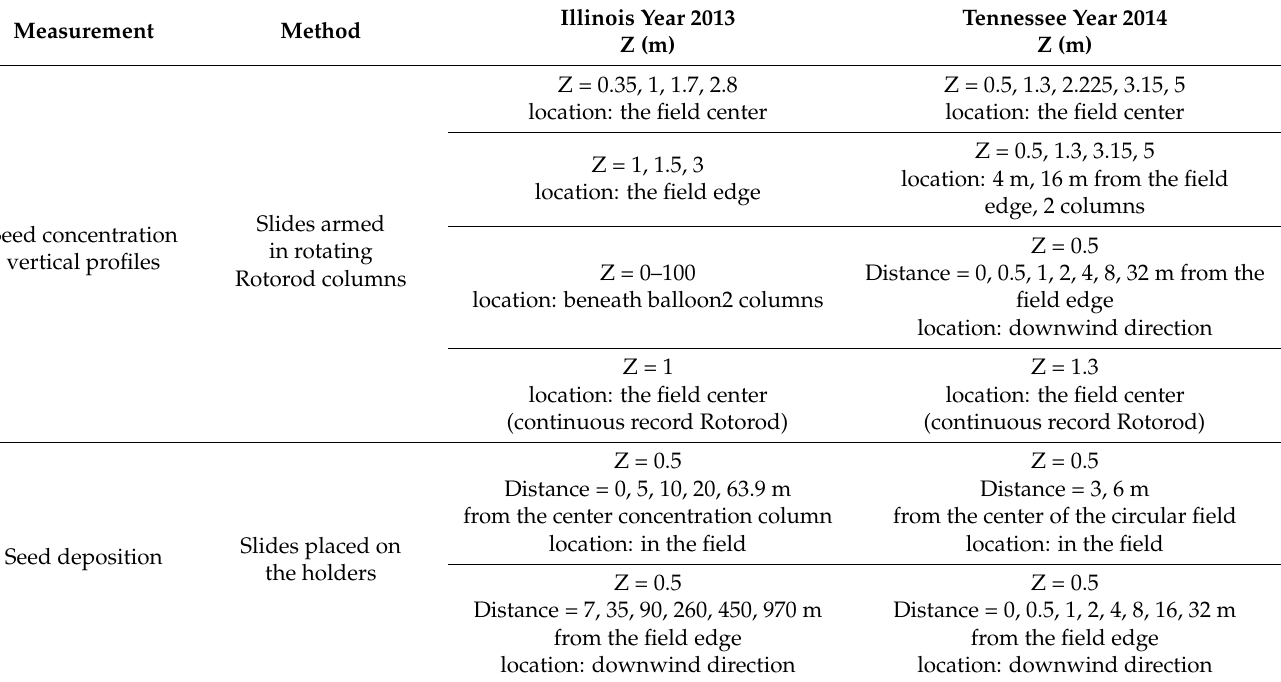
Table 1. Measurements made and methods used during Illinois and Tennessee experiments.